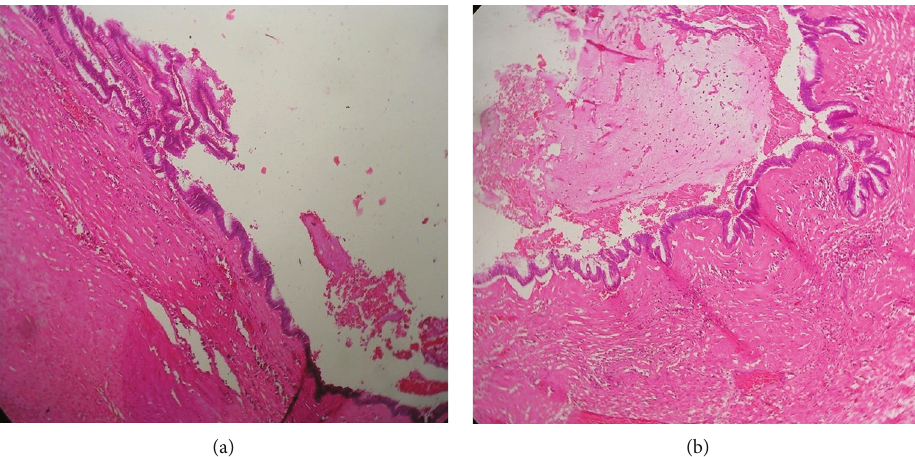
Figure 2: Photomicrograph of low-grade appendiceal mucinous neoplasm. (a) It shows a single layer of neoplastic mucin secreting epithelium resting on a fi brotic wall. (b) It shows pushing invasion into the fi brotic wall and luminal mucin. H&E. × 20